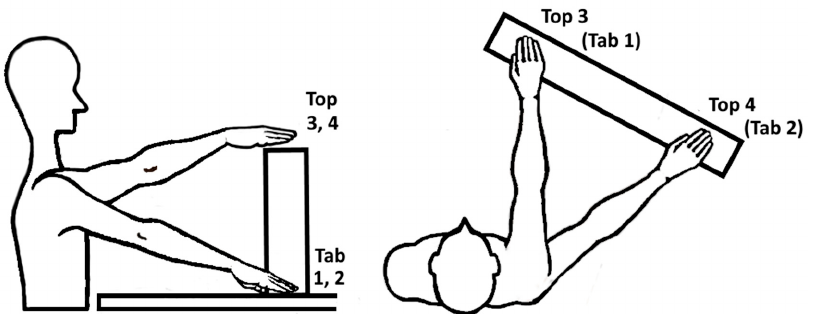
Figure 2. Experimental set up in sagittal and top view including the target locations: Tab 1; in ipsilateral arm length, Tab 2; in abducted arm length, Top 3; ipsilateral arm length, Top 4; in abducted arm length. Block objects: BL (big light block, 108 g), BW (big wooden block, 490 g) and BH (big heavy block, 1008 g).